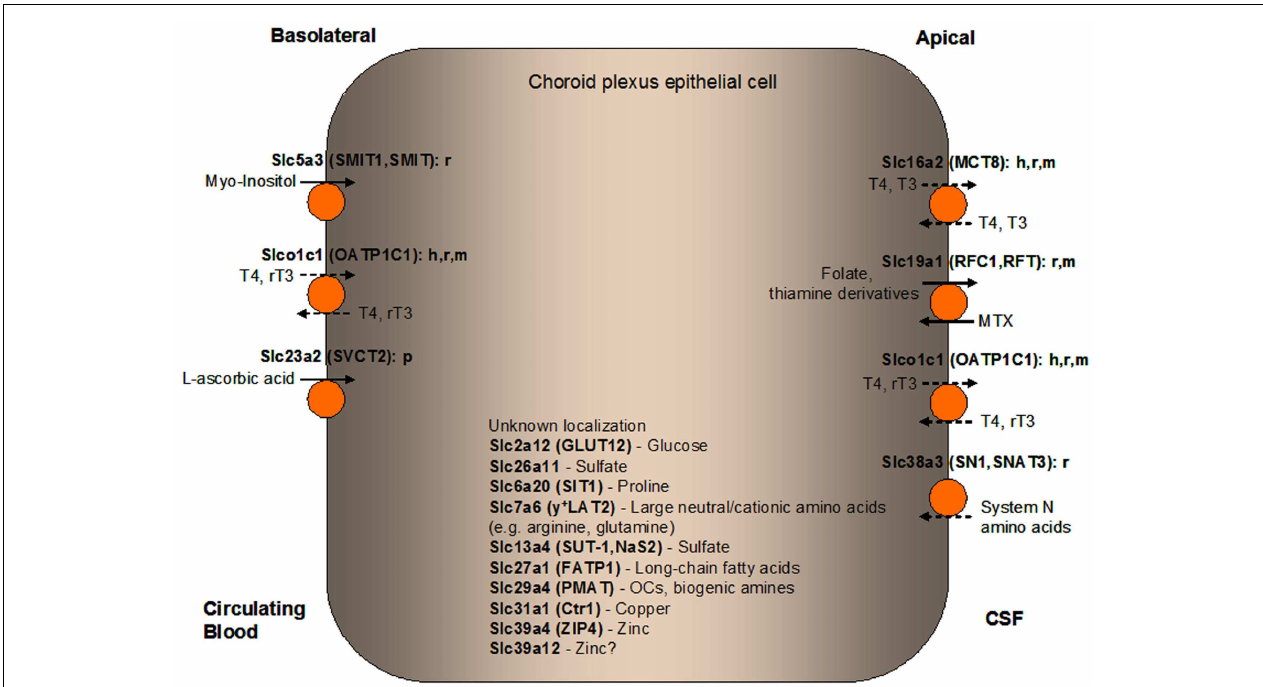
species as indicated (h, human; r, rat; m, mouse; p, porcine). Major classes or representatives of substrates for each transporter are shown (T3, triiodothyronine; rT3, reverse triiodothyronine;T4, thyroxine; MTX, methotrexate; OCs, organic cations). Relatively well-established directionality of transport is shown by solid arrows while dashed arrows indicate potential directionality of transport.Transporters with unknown CP localization are listed along with their main substrates. CSF, cerebrospinal fluid.